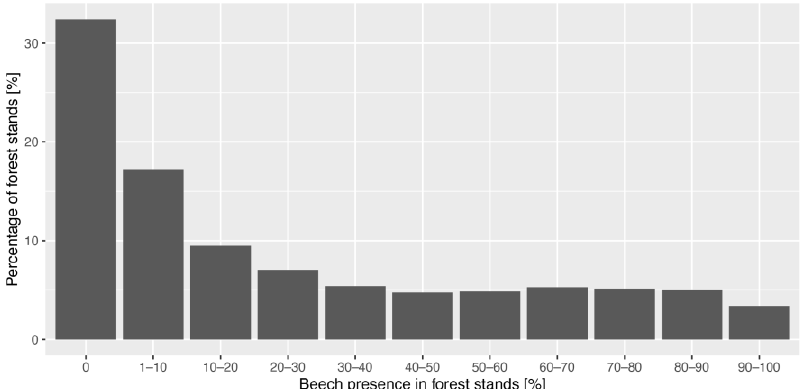
Figure 6. Percentage of Fagus sylvatica in the growing stock of 341,341 forest stands in